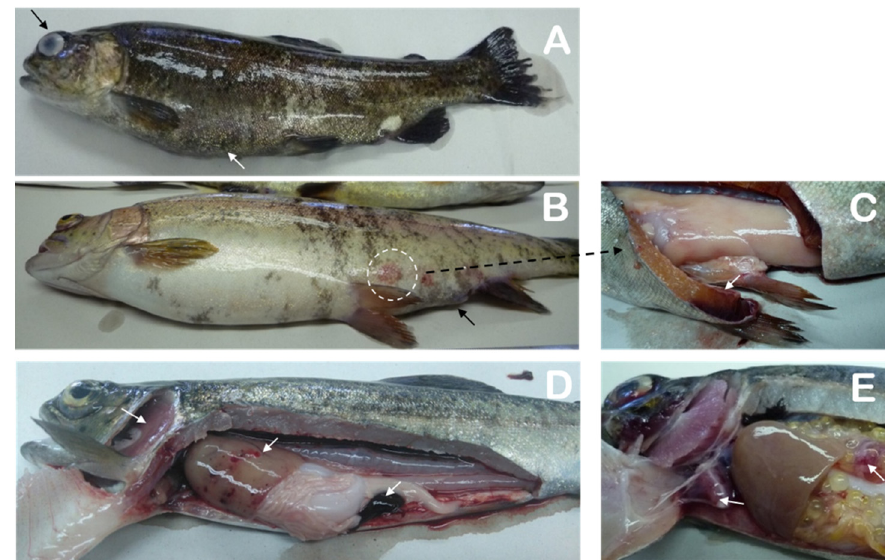
Figure 1. Rainbow trout with Lactococcus garvieae lesions. Shown are ( A ) melanosis and abdominal bulging (white arrow), as well as exophthalmia and corneal opacity (black arrow); ( B ) hemorrhaging on the base of the fins, anal prolapse (black arrow), hemorrhages on the skin, and rounded muscle bulges (2–3 cm diameter) on the skin (circle) and ( C ) in the deep-muscle layers. Necropsies revealed ( D ) generalized pallor, hemorrhages in the liver and intestine, and splenomegaly (white arrows), as well as ( E ) fibrinous adhesions in the heart (arrow) and hemorrhages in the ovary (arrow).